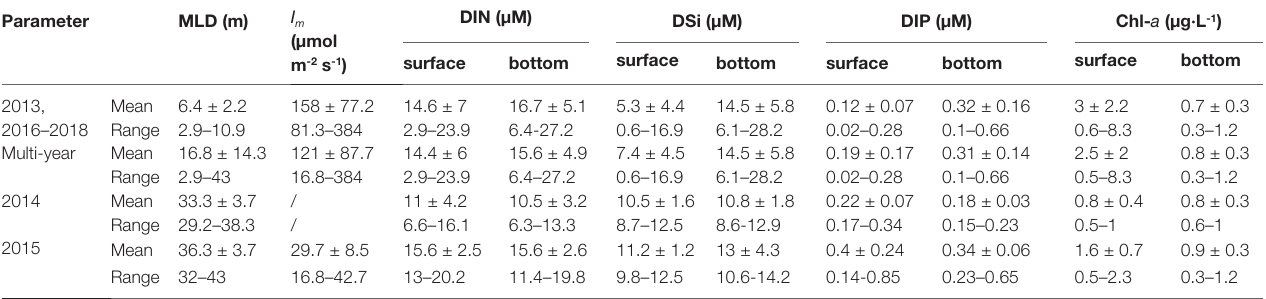
TABLE 3 | Mean, standard deviations, and max-min ranges of the ecological variables in the CWZ during the summer of multi-year average, 2014 and 2015, based on surveys data.